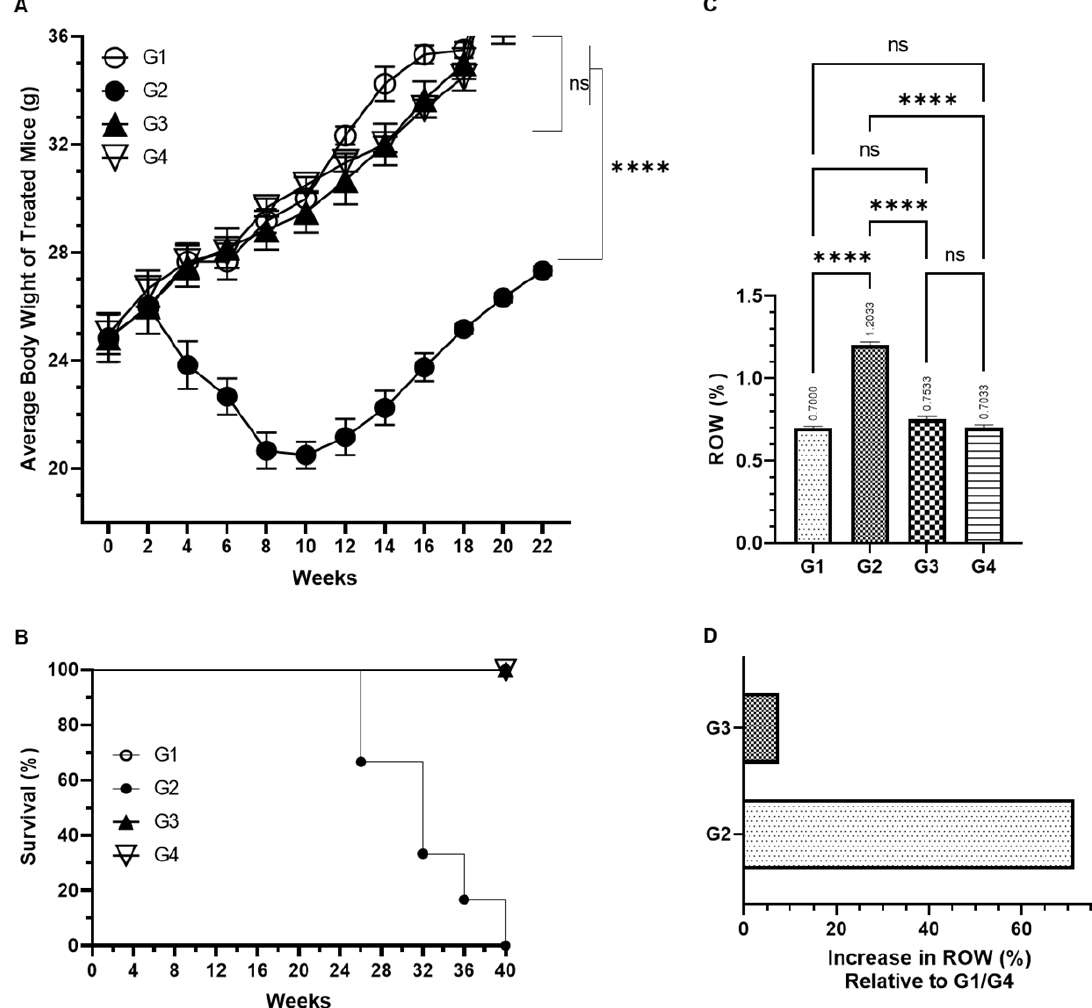
Figure 4. Effect of AAE on carcinogen-moderated ( A ) ABW, ( B ) survival, ( C ) RLW, and ( D ) increased percentage of RL relative to G1/G4. The values are given as the SEM of 5 animals in each group for ( A ) and ( C ), whereas it is ten mice for ( B ). NS No significance within the groups, **** Significant difference between the groups, p -value < 0.0001.